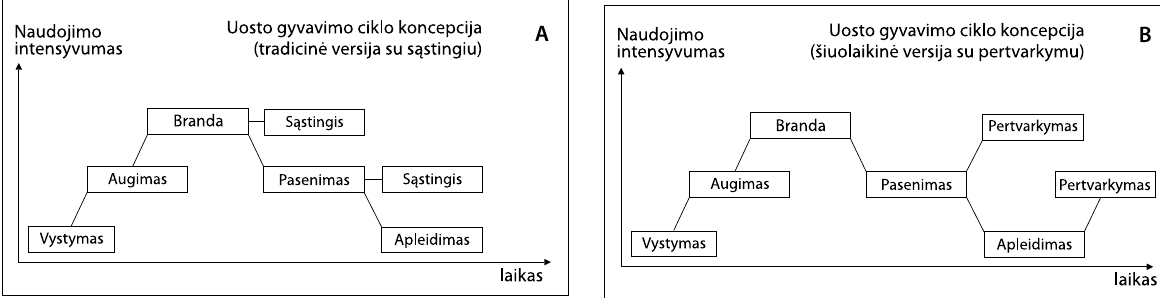
Fig. 2. Seaport life cycle, traditional (a) and contemporary (b)